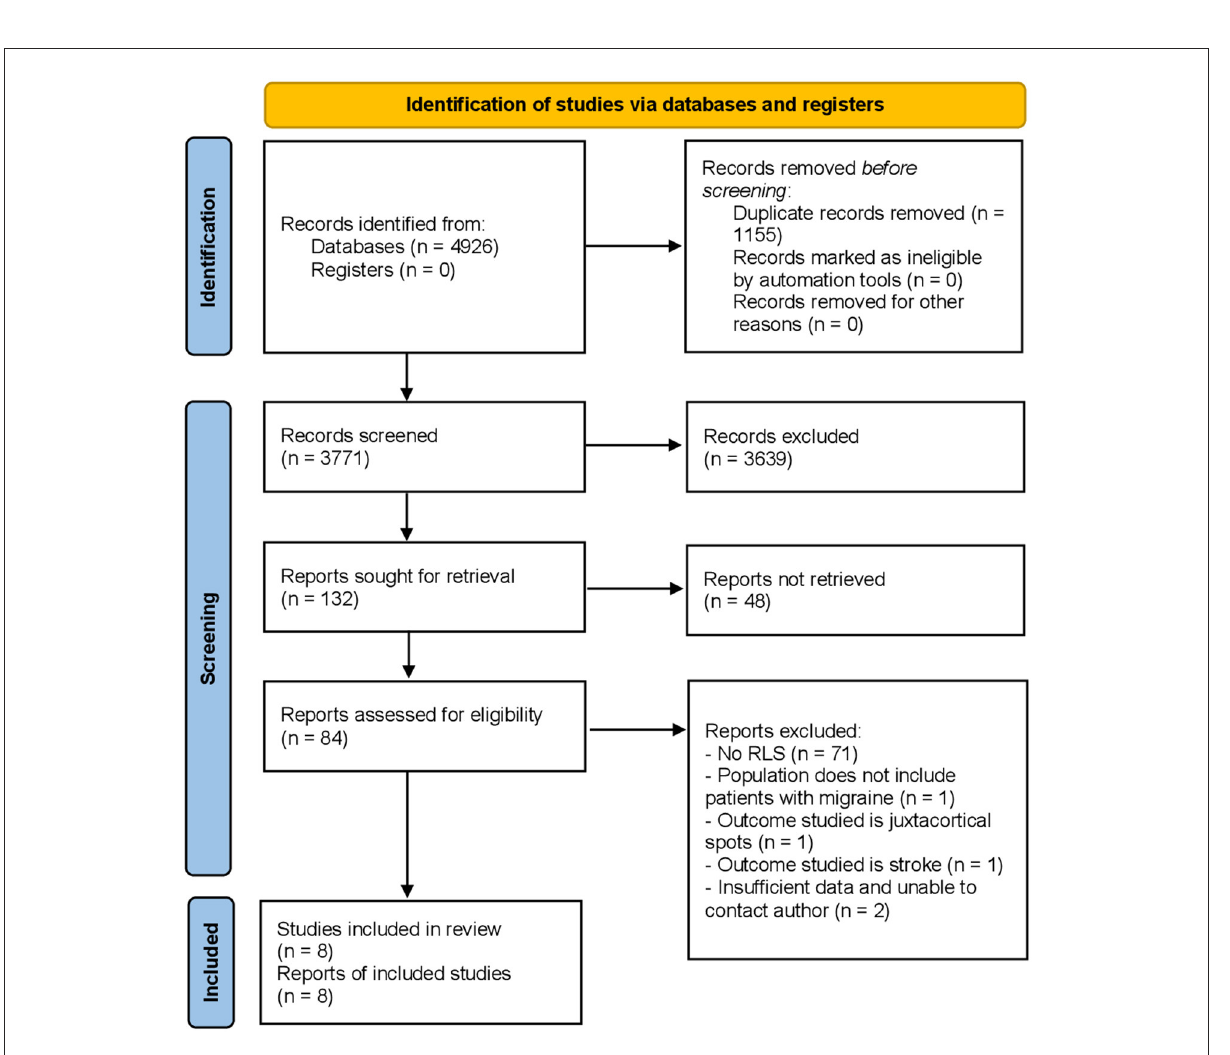
FIGURE1 PRISMA 2020 flow diagram for new systematic reviews which included searches of databases and registers